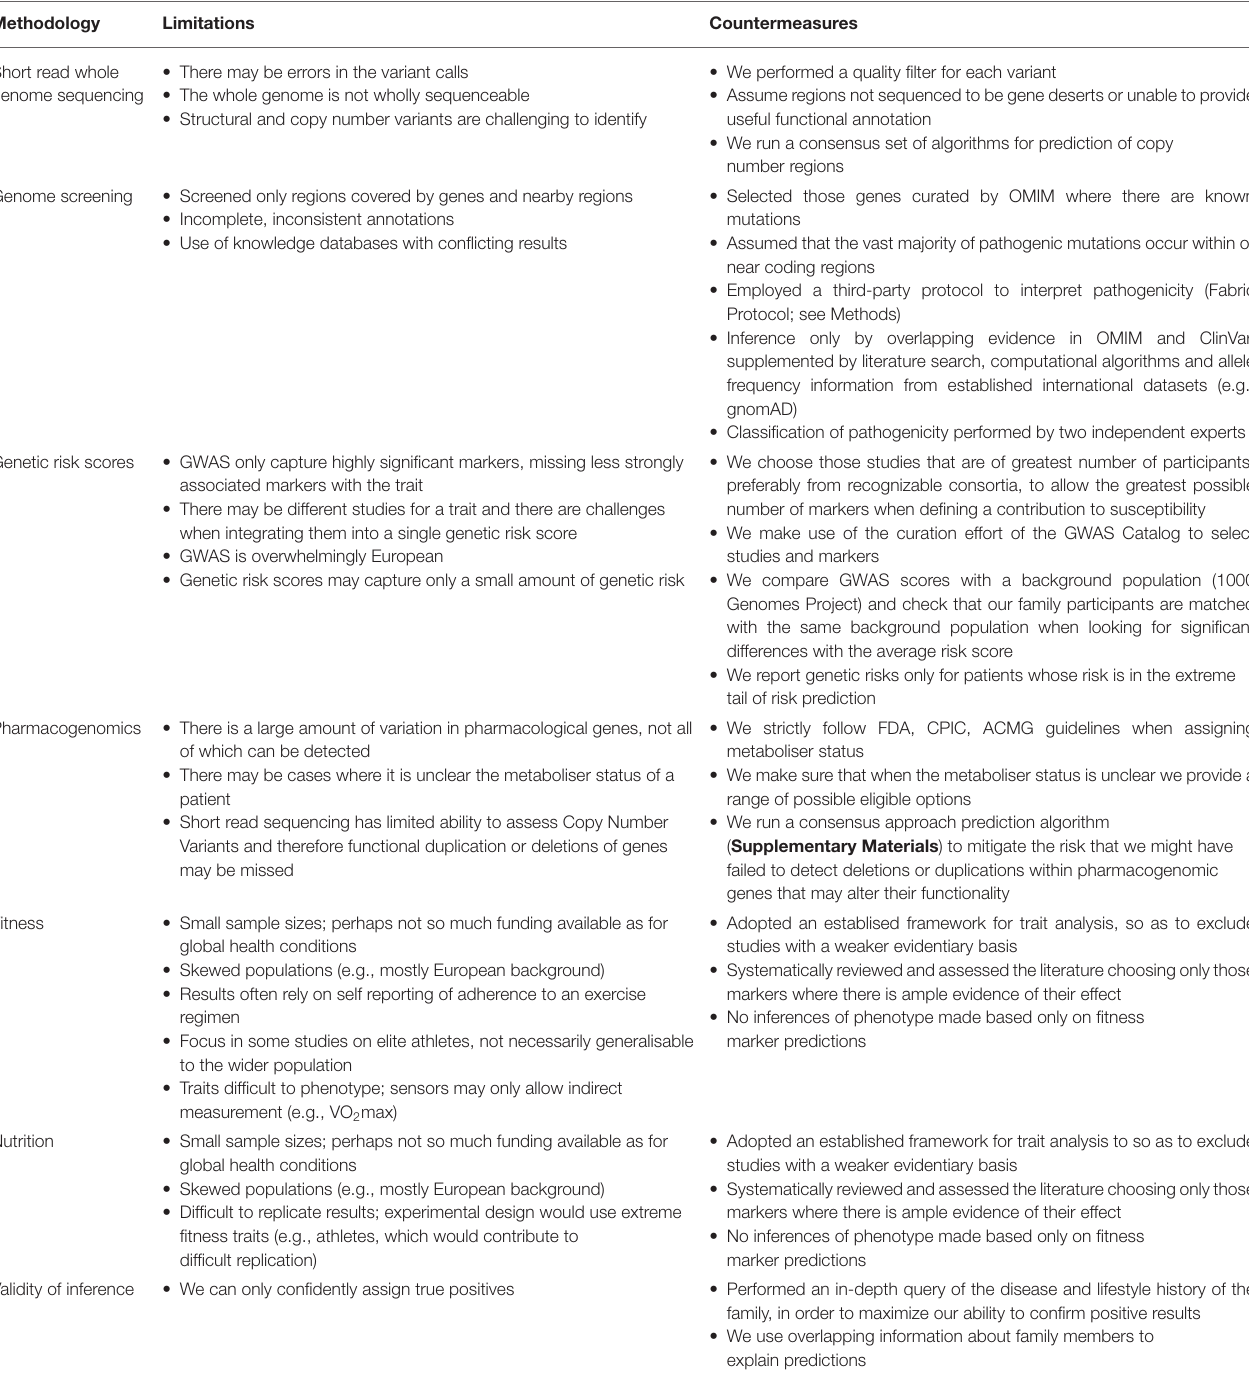
TABLE 8 | List of known limitations of the methodologies we have performed for our analysis and the countermeasures we have adopted to contain them.